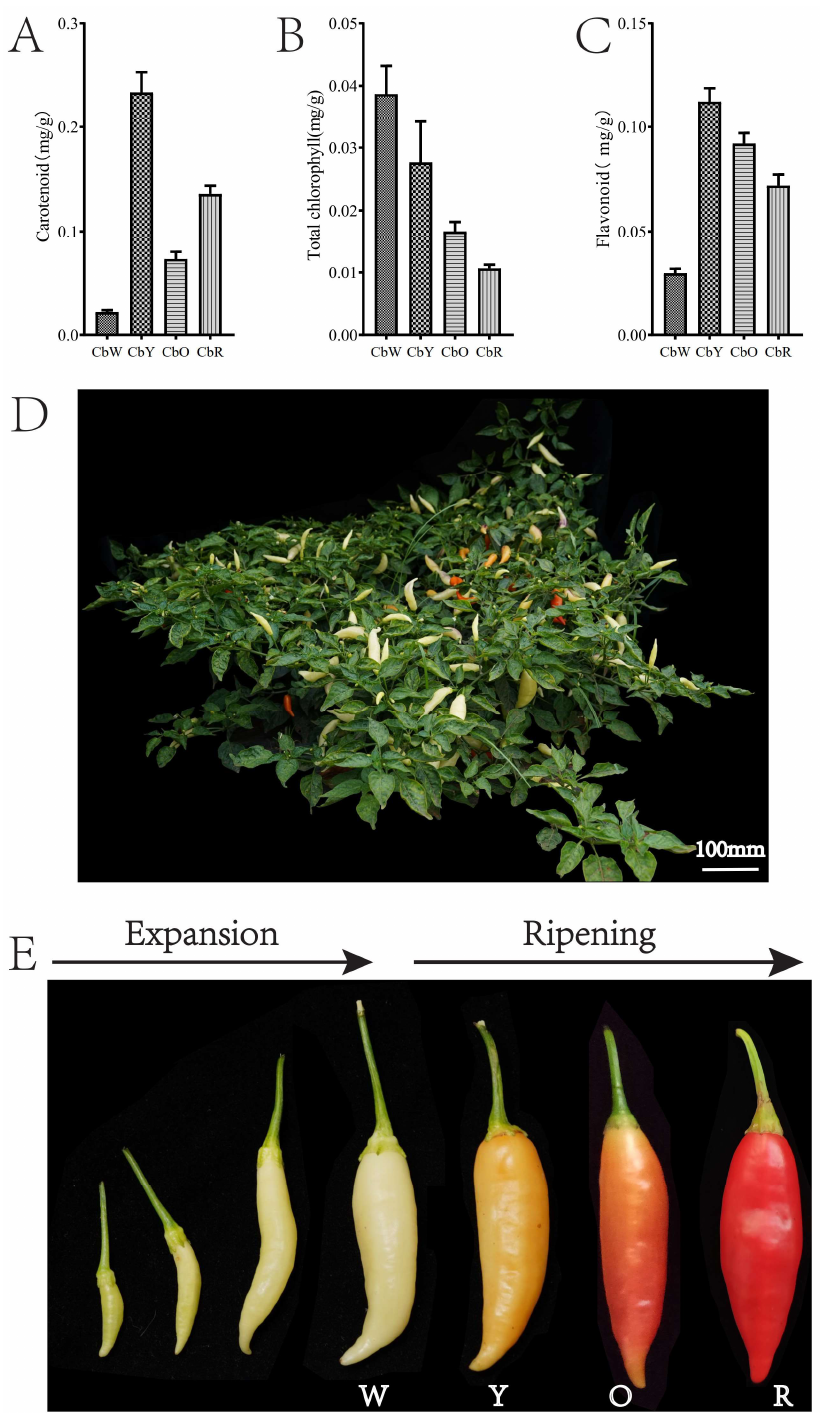
Figure 1. Plant, fruit and physiological index contents of pepper HNUCB0081. ( A – C ) Total carotenoids, chlorophylls and flavonoids in fruits of pepper at four periods; ( D ) plants; ( E ) fruits at different developmental periods (W: CbW, Y: CbY, O: CbO, R: CbR).